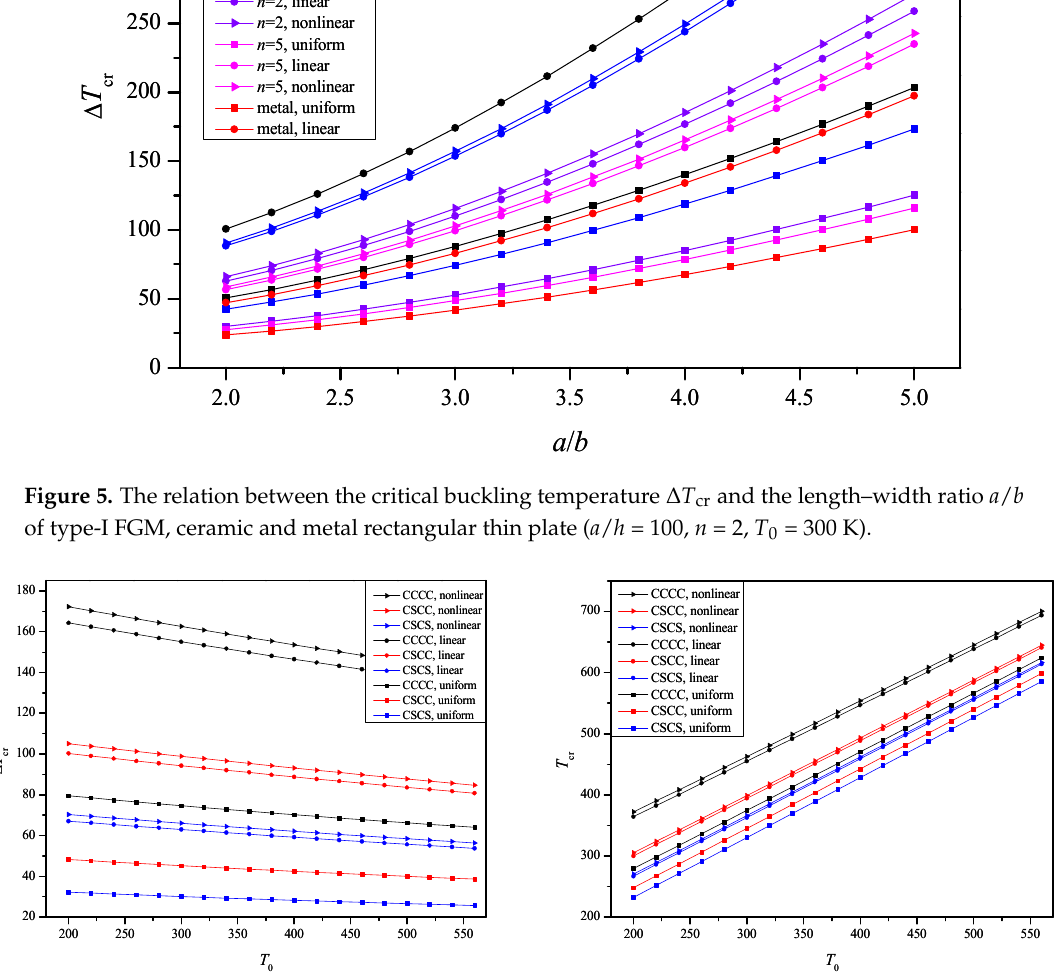
Figure 6. ( a ) The relation between Δ T cr and the initial temperature T 0 of type ‐ I FGM rectangular thin plate ( a / h = 100, a / b = 2, n = 2); ( b ) The relation between T cr and the initial temperature T 0 of type ‐ I FGM rectangular thin plate ( a / h = 100, a / b = 2, n = 2).